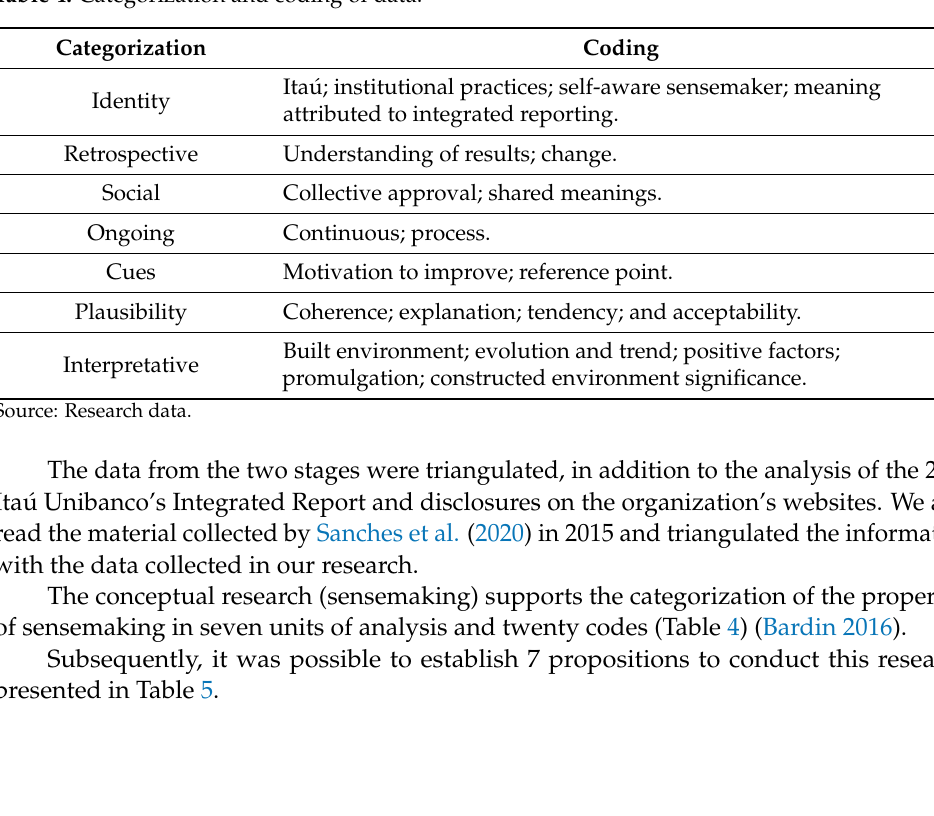
Table 4. Categorization and coding of